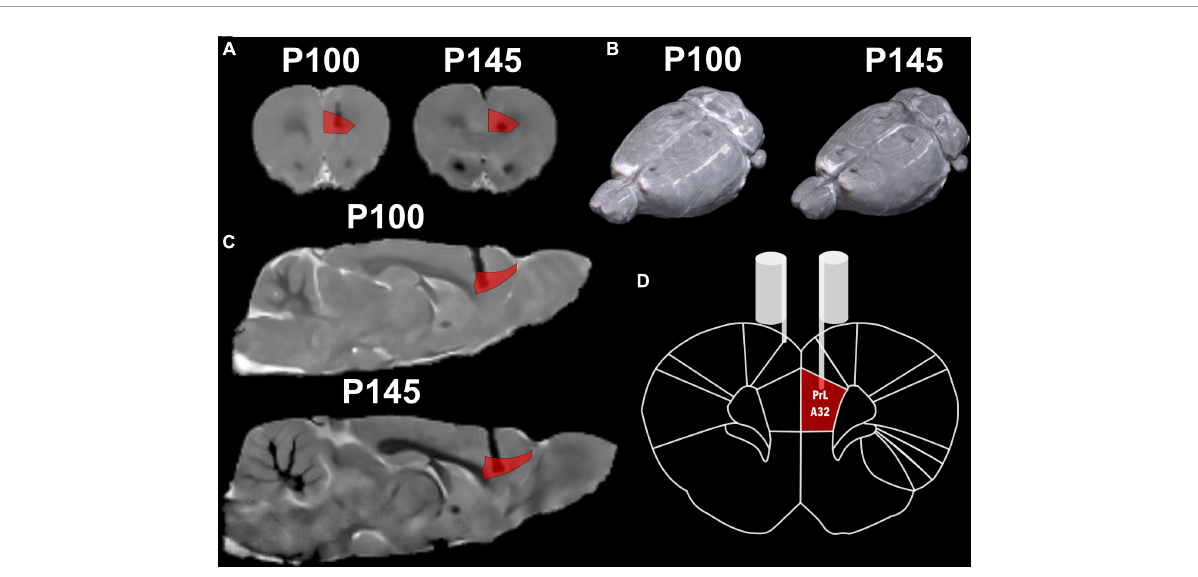
FIGURE5 Structural MRI with a reference atlas (Paxinos and Watson, 2006) of Rat 2. (A) Coronal slide with atlas region PrL/A32 (prelimbic) region in red and the shadow of the electrode. (B) Render of rat brain dorsal view with electrodes marks and posterior to lambda two fixation screws. (C) Sagittal slide with atlas region PrL/A32 in red. (D) Schematic coronal slide from the atlas, with the left electrode on PrL/A32 and the right on the surface of the cortex.